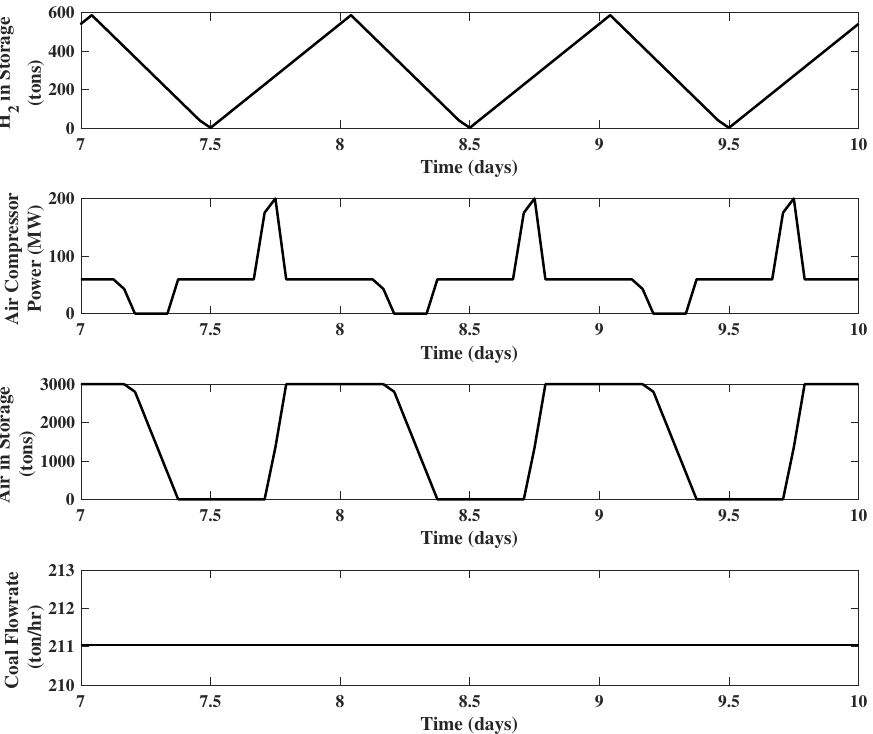
Figure 4. Closed-loop simulation of EMPC using a 24 h prediction horizon for Example